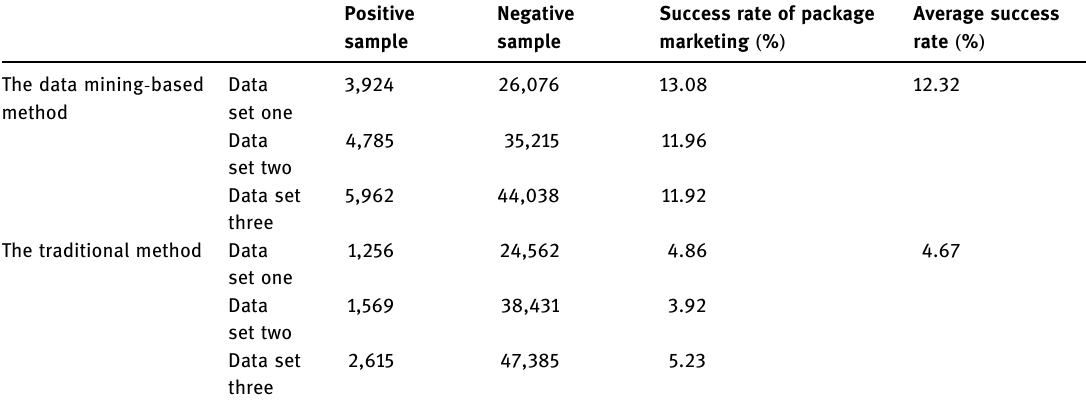
Table 1: Comparison of marketing success rate between the data mining - based method and the traditional method